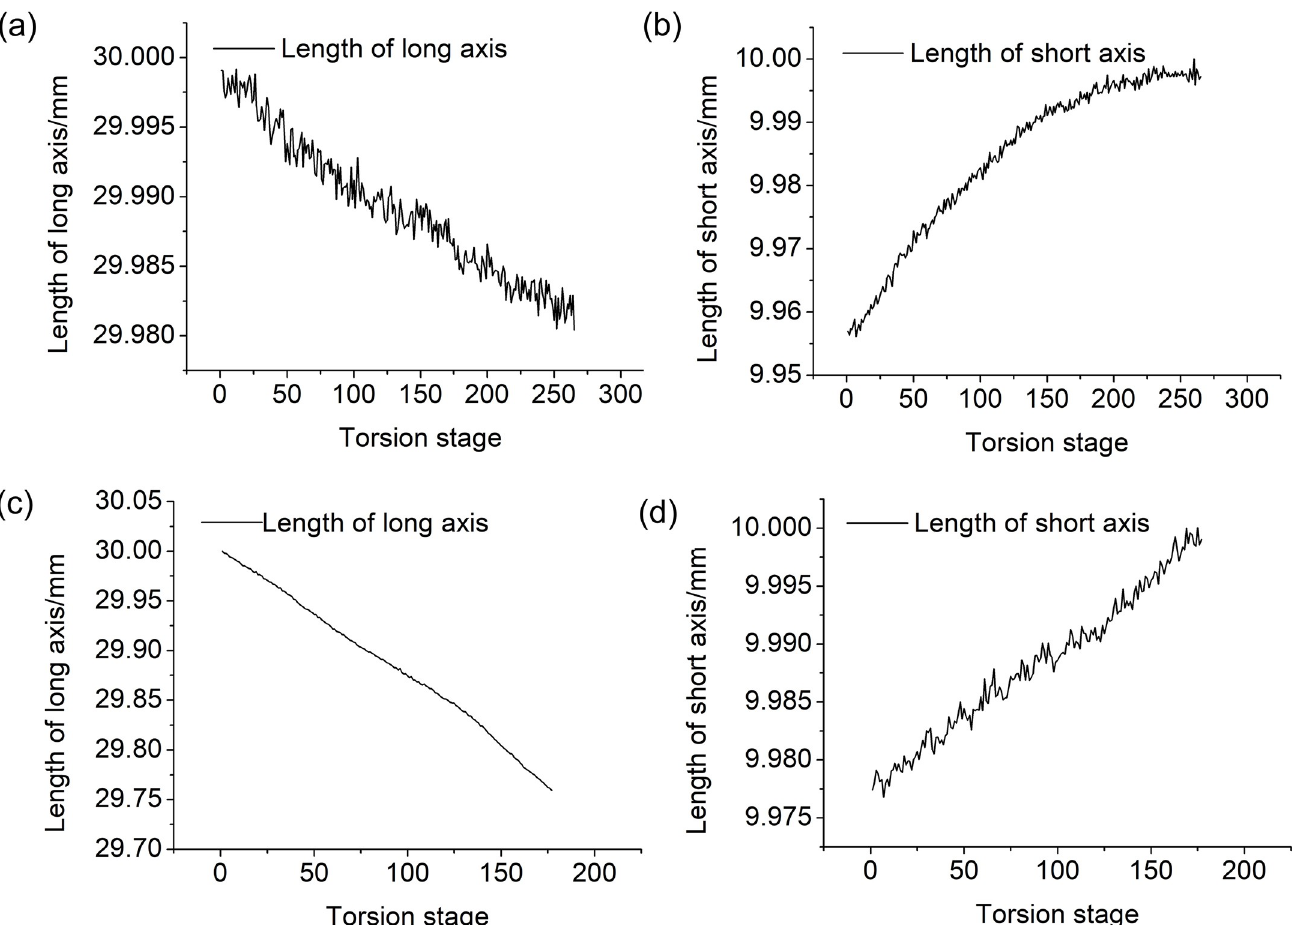
Fig 5. Variations of length of both long axis and short axis (a) Length of long axis under single torsion load with 0.3˚/s torsion speed (b) Length of short axis under single torsion load with 0.3˚/s torsion speed (c) Length of long axis under single compression load (d) Length of short axis under single compression load.